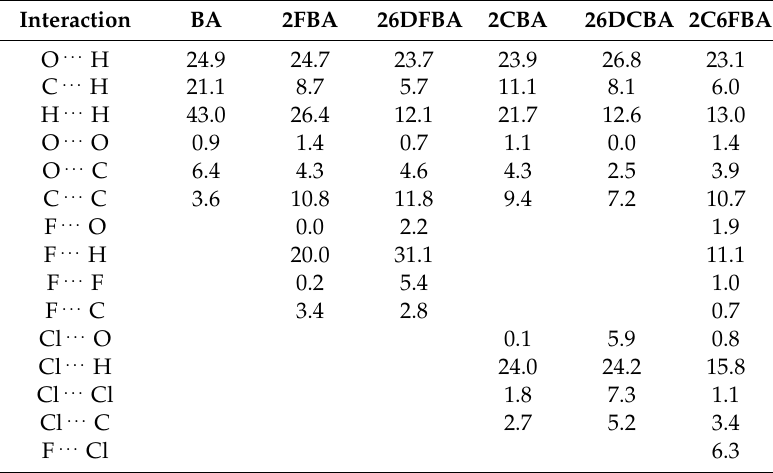
Table 9. Atom ... atom interactions (%) in the crystals of the studied compounds, according to the Hirshfeld method ( d norm